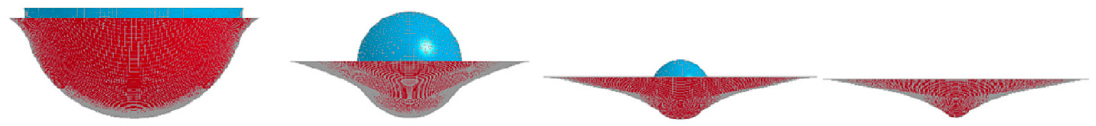
Figure 4. Punch test simulation with different punch sizes [33].